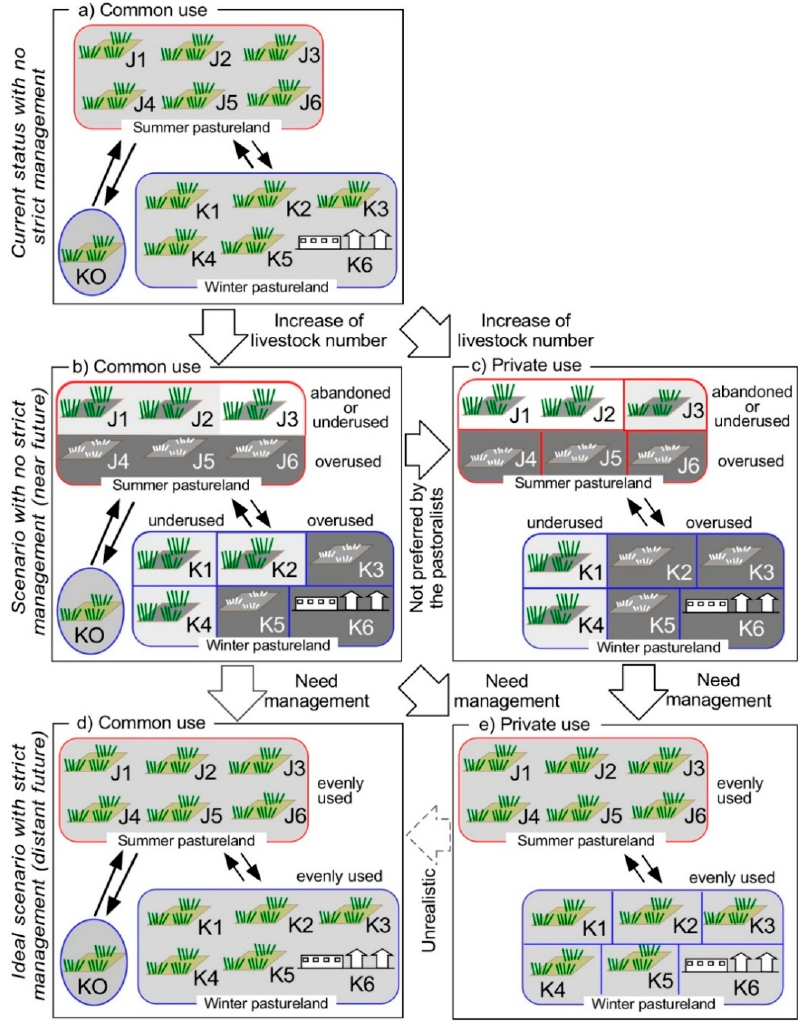
Figure 7. The current pastureland tenure and its future scenarios in the Karakul area. J1-6: jailoo ;